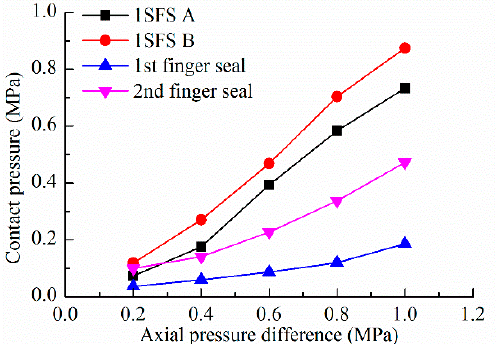
Figure 13. Comparison of contact pressure between 2SFS and 1SFSs.